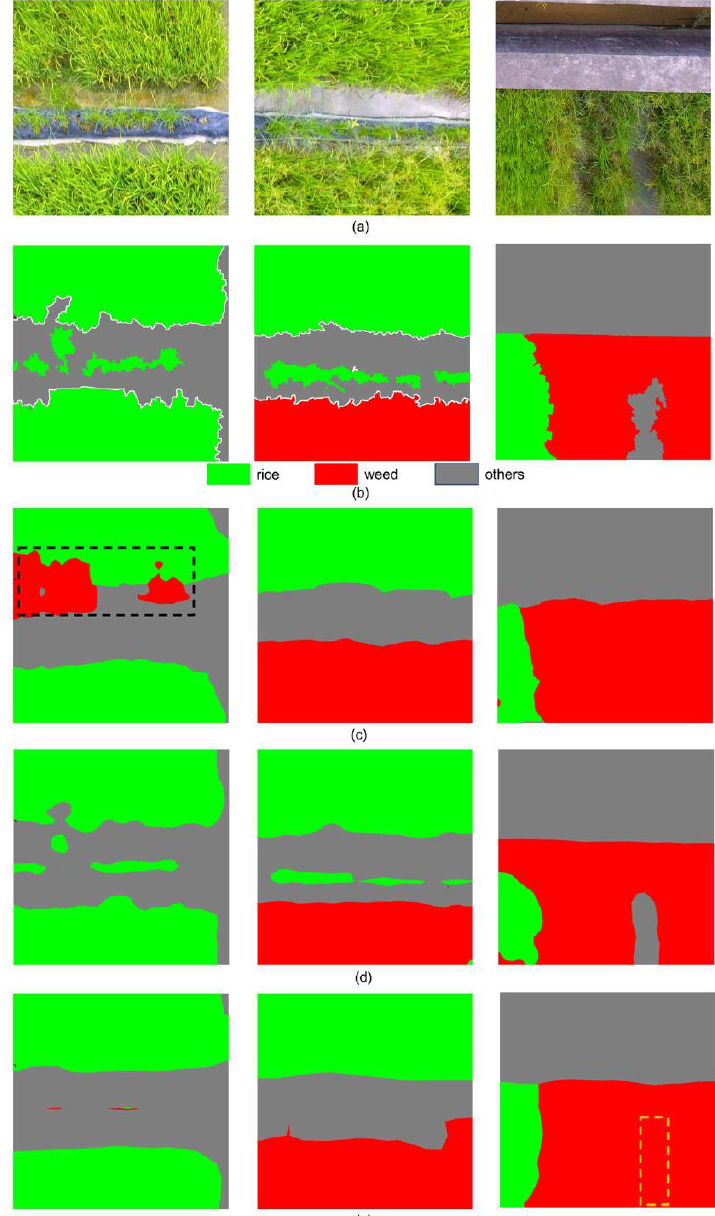
Figure 11. Classification results of the FCN with distinct pre-trained CNNs. ( a ) Real UAV image; ( b ) Ground truth results; ( c – e ) Results acquired by FCN-AlexNet, FCN-VGG16 and FCN-GoogLeNet, respectively [34].